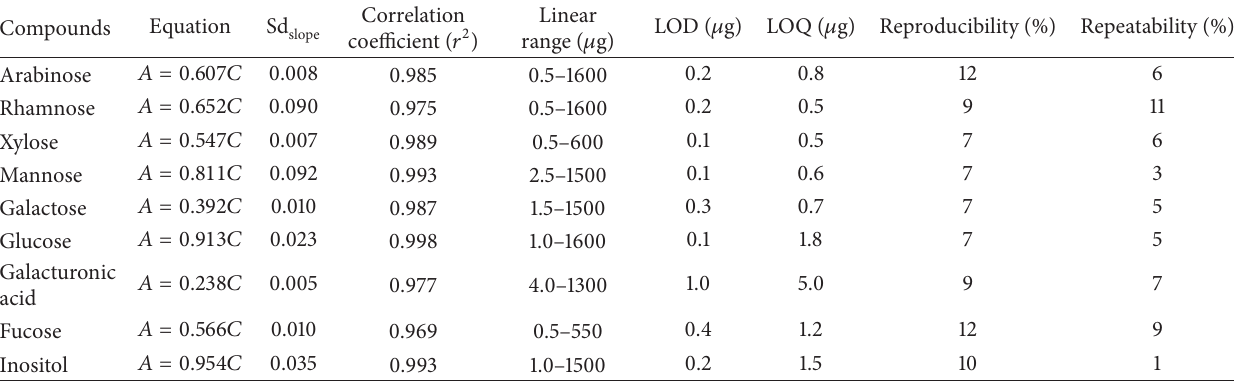
Table2:Calibrationcurvedata,calculateddetection(LOD),andquantification(LOQ)limitsandprecision(repeatabilityandreproducibility) of the monosaccharide standards detected by GC-MS.